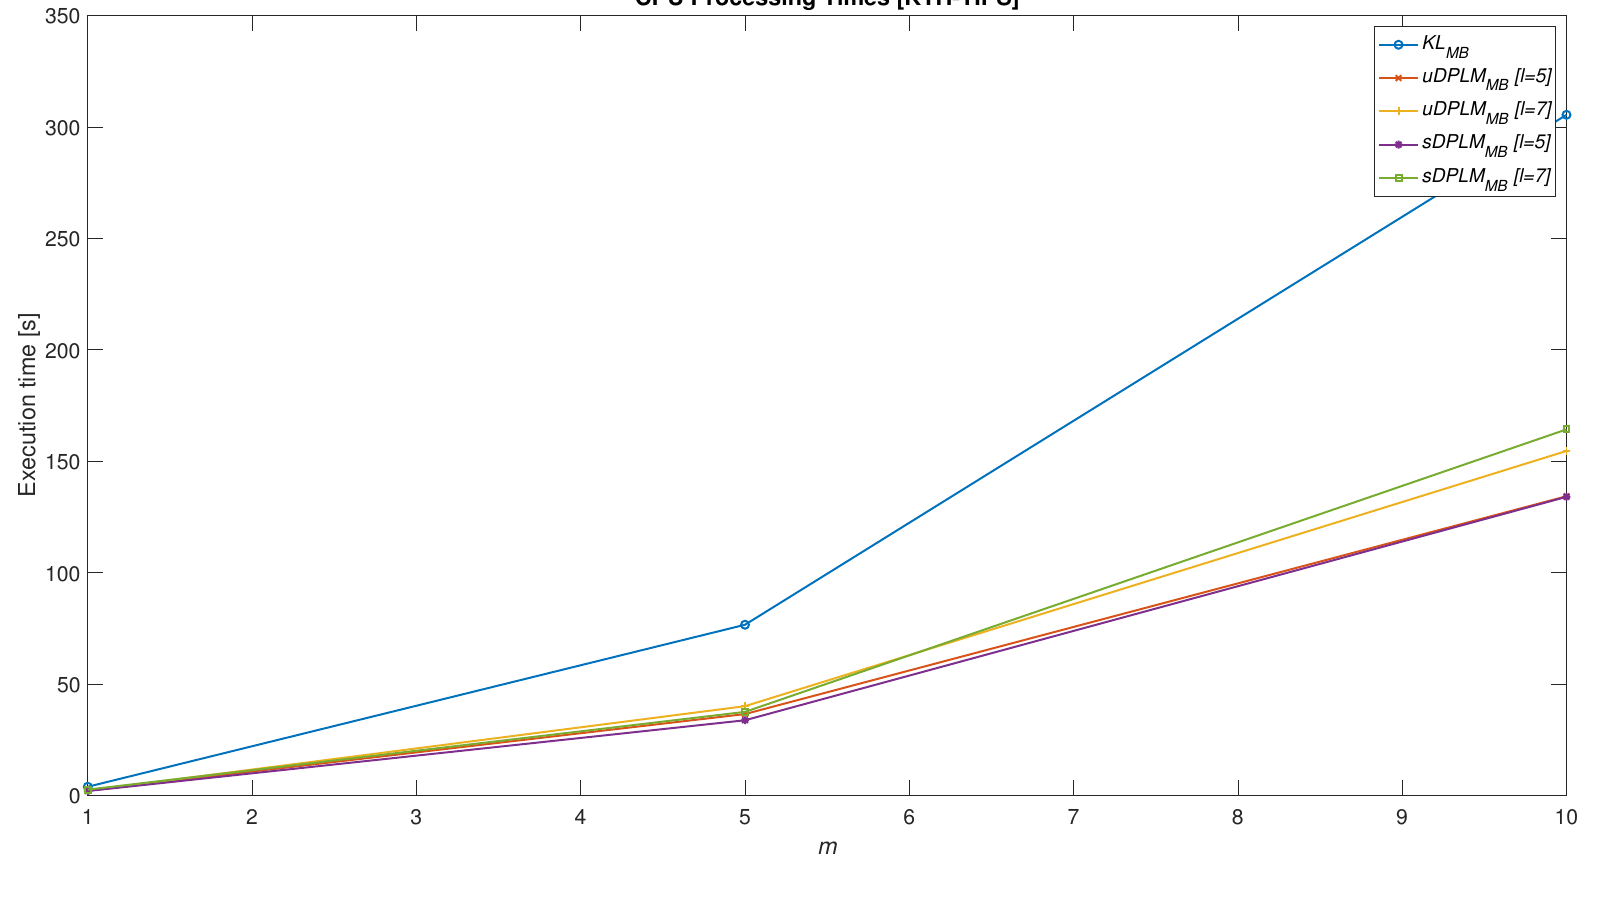
Figure 6. CPU processing times for the KTH-TIPS database, DPLM MB vs. KL MB